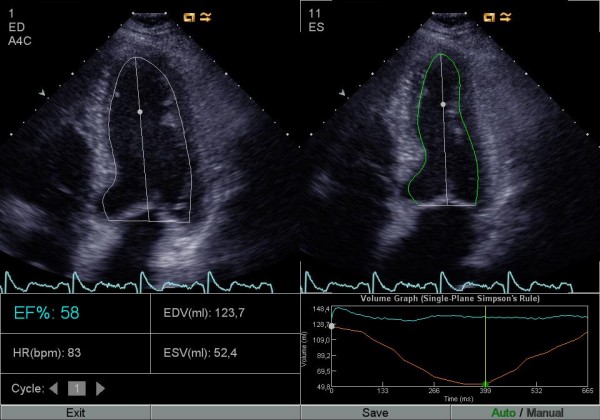
AutoEF before and after manual correction. The same images as Figure 1 after manual correction of the endocardial border by the operator. This panel of images shows an example of underestimation of the length of the longaxis of the left ventricle by the software.